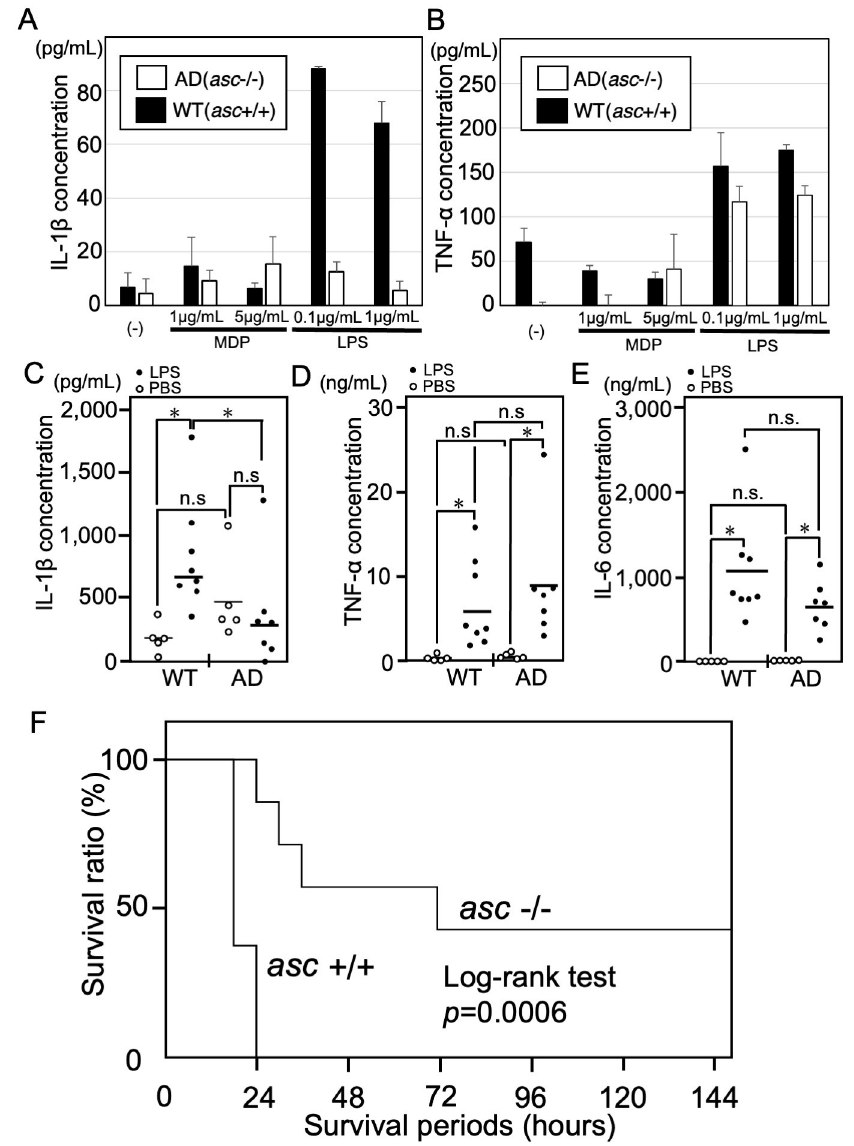
Fig 2. IL-1 β secretion is suppressed in AD mice, which survive for longer than WT mice after LPS challenge. (A, B) Bone marrow cells (2 × 10 5 ) were incubated for 8 h with the indicated concentrations of MDP or LPS. IL-1 β (A) and TNF- α (B) concentrations in culture supernatants were measured by ELISA. Results are presented as the mean SD of triplicate cultures. Data are representative of three independent experiments. (C–E) WT and AD mice were injected intraperitoneally with 50 μ g/g LPS in PBS (black circles) or PBS alone (white circles). At 4 h after LPS challenge, serum IL-1 β (C), TNF- α (D), and IL-6 (E) concentrations were measured by ELISA. Results are plotted and the mean value are presented. � p- value < 0.05 was considered significant. (F) A Kaplan–Meier survival curve for WT ( asc +/+) mice (n = 8) and AD ( asc -/-) mice (n = 7) injected with 50 μ g/g LPS. Data were analyzed using the log-rank test ( p =